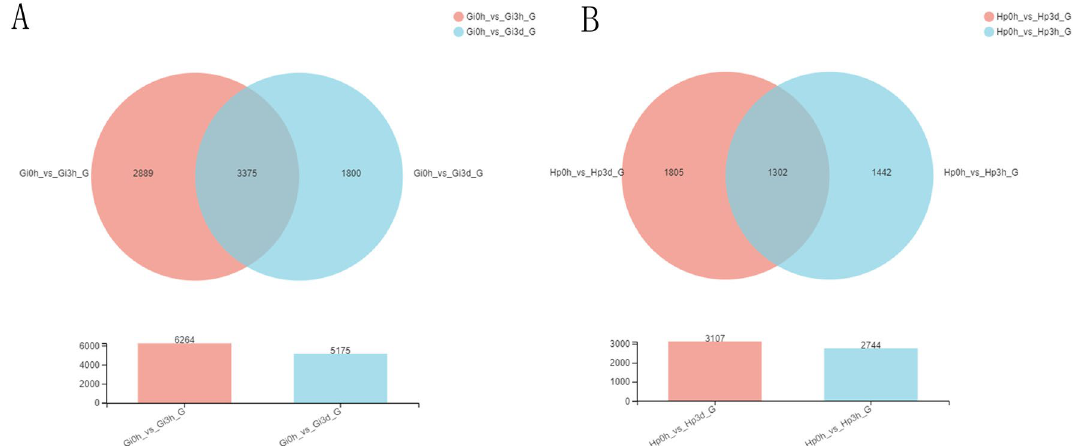
Figure 4. Venn diagram of differentially expressed genes (DEGs) in different comparisons. The overlaps represent the number of intersections of unigenes shared by the control group (0 h) and the two experimental groups (3 h and 3 d). Gi, gill; HP, hepatopancreas; 0 h, control; 3 h, Cd 2+ treated 3 h; 3d, Cd 2+ treated 3